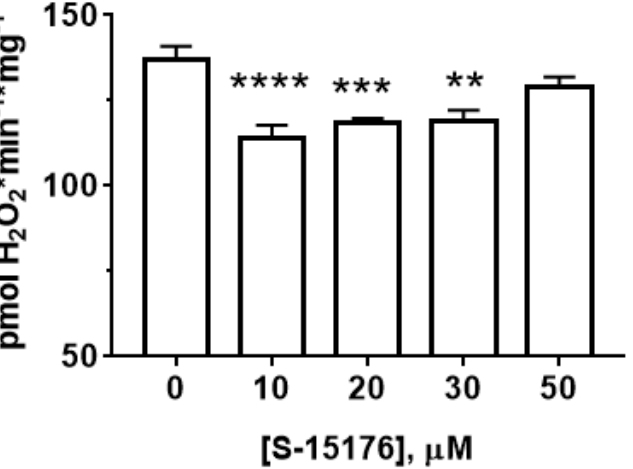
Figure 3. Effect of S-15176 on the rate of H 2 O 2 production by rat liver mitochondria. Data represent the mean ± SEM ( n = 5). ** p < 0.01, *** p < 0.005, and **** p < 0.001.